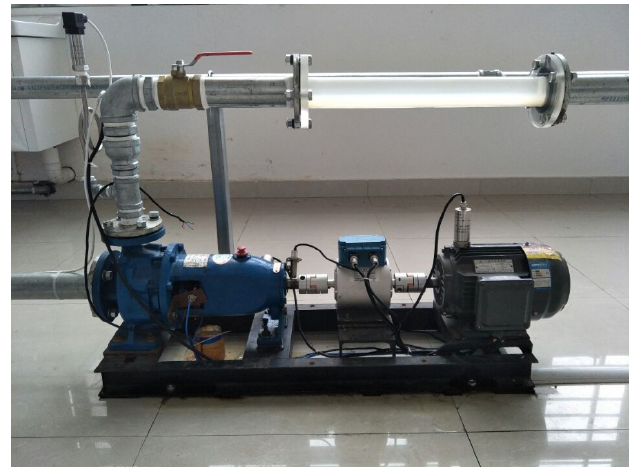
Figure 2. Centrifugal pump test device.